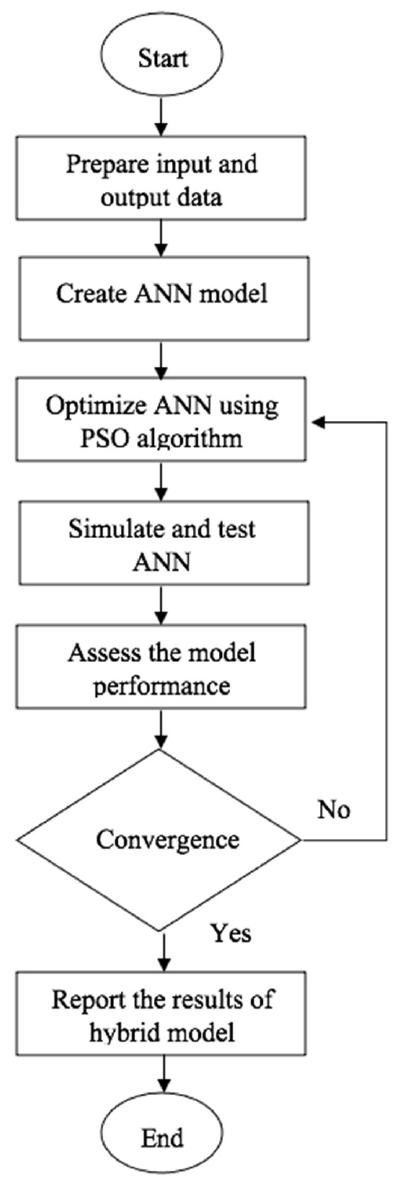
Figure 3. Flowchart of ANN model coupled with PSO algorithm.